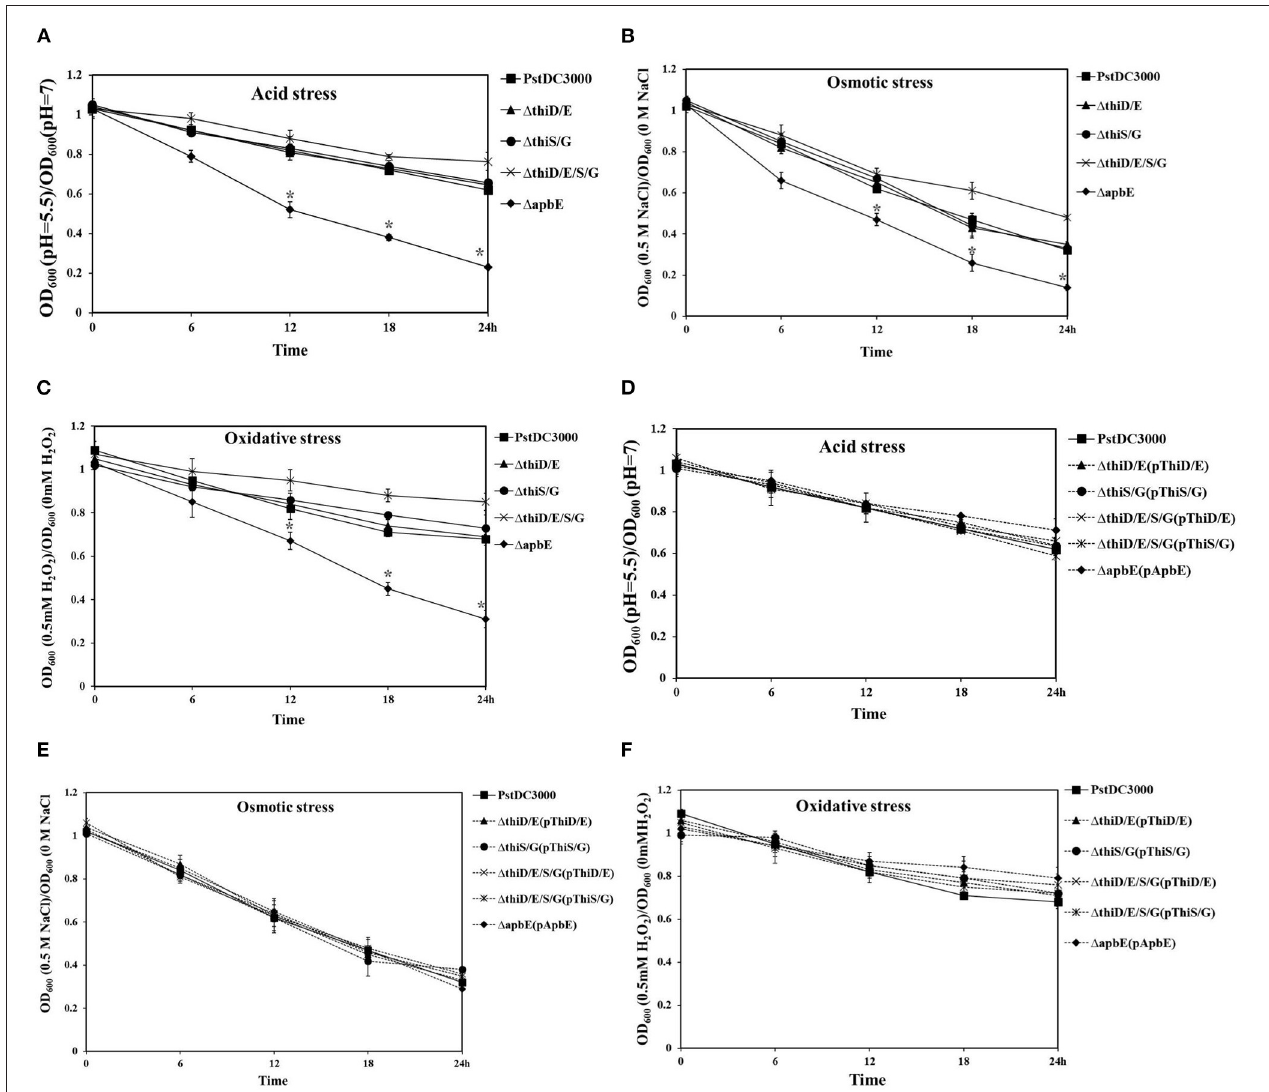
FIGURE 3 | Thiamine-related genes affected tolerance to acid, oxidative, and osmotic stresses of Pst DC3000. (A) Pst DC3000 wild type, the thiD/E , thiS/G , thiD/E/S/G , and apbE mutant cells of overnight cultures in KB were washed and resuspended to OD 600 = 0.01 in KB liquid medium with pH 5.5. The phenotype was observed after incubation at 28 ◦ C for 24h and bacterial growth was monitored by measuring OD 600 . (B) All the mutant cells were grown in KB liquid medium with 0.5M NaCl and incubated at 28 ◦ C for 24h. (C) All the mutant cells were grown in KB liquid medium with 0.5mM hydrogen peroxide (H 2 O 2 ) and incubated at 28 ◦ C for 24h. (D) All the complementation strains were grown in KB liquid medium with pH 5.5. (E) All the complementation strains were grown in KB liquid medium with 0.5M NaCl. (F) All the complementation strains were grown in KB liquid medium with 0.5mM H 2 O 2. The solid line represents mutant strains; the dashed line represents complementation strains; and the vertical bars represent SDs. Experiments were performed in triplicate and repeated three times. Statistical tests were performed and statistically significant differences were determined by one-way ANOVA and P -values were < 0.05 [an asterisk (*) indicates P < 0.05, mutant and complementation strains vs. the WT Pst